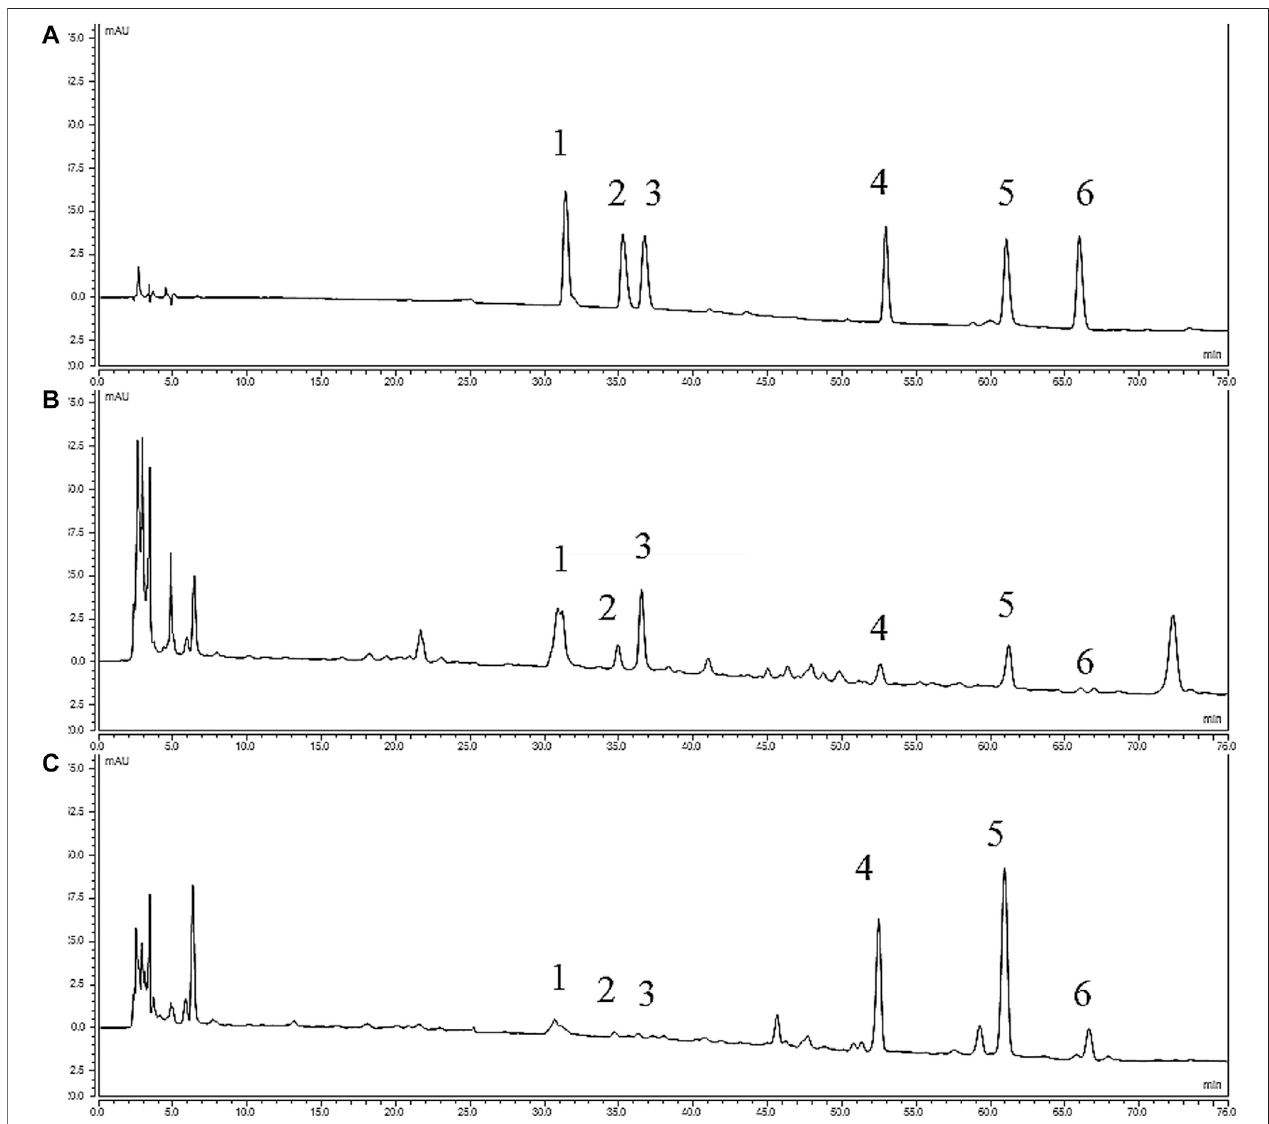
FIGURE1| HPLCchromatogramsofvariousalkaloids. (A) Standards; (B) YF; (C) ULRA;(1),Benzoylmesaconine;(2),Benzoylhypaconine;(3),Benzoylaconine;(4), Mesaconitine;(5),Aconitine;(6),Hypaconitine;HPLC,highperformanceliquidchromatography;ULRA,unprocessedlateralrootof Aconitumcarmichaelii ;YF,Yinfupian.